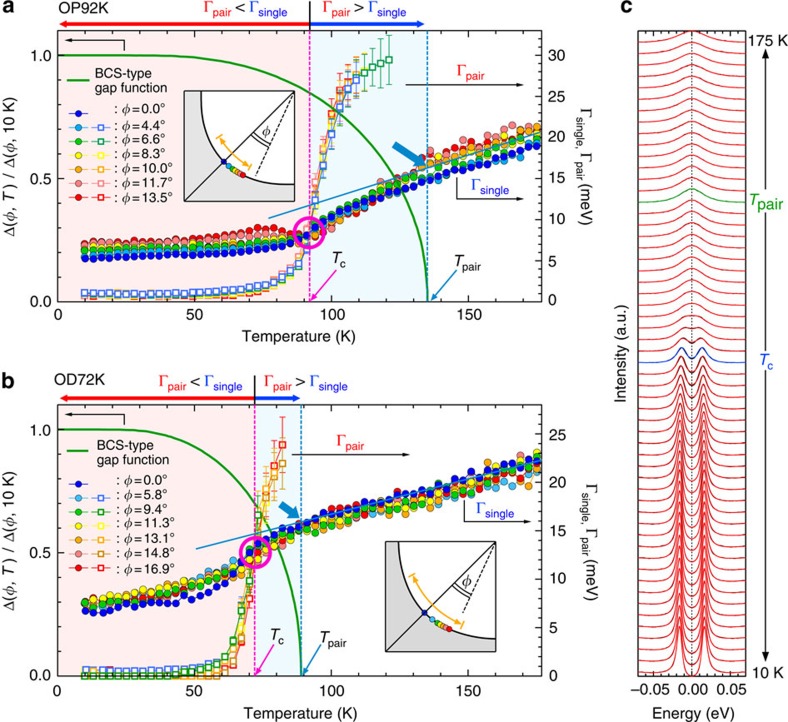
Extracted parameters of the minimal model spectral function required to reproduce the ARPES spectra.(a) The BCS-type gap function used for the fitting to the OP92K data (a green curve), and the obtained single-particle scattering rate (Γsingle, or Γ1) and the pair-breaking rate (Γpair, or Γ0) in equation (1). (b) The fitting results same as in a, but for the OD72K data. The values of Γpair at high temperatures are not plotted, since the spectral shape is insensitive to the Γpair when Δ is small or zero, and thus it is impossible to determine the value. A small hump seen in the Γpair around 75 K for φ=11.7° and 13.5° in a comes from a slight difficulty of fitting to the spectra with a peak-dip-hump shape due to the mode coupling, which appears below Tc and gets pronounced with approaching the antinode. Magenta circle marks the crossing point of Γsingle(T) and Γpair(T). Large blue arrow indicates the temperature, at which the Γsingle(T) deviates from a T-linear behaviour on cooling. (c) ARPES spectra (black curves) and fitting results (red curves) providing the parameters for φ=13.5° in a. Error bars in a and b represent standard deviations in fitting the model spectral function to the ARPES spectra.